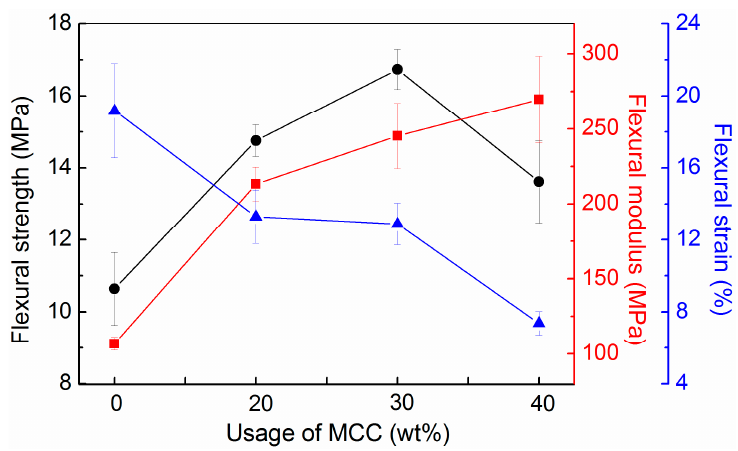
Figure 4. Effect of MCC loading on the flexural properties of MCC/AESO composites. ( Flexural strength; Figure 4. E ff ect of MCC loading on the fl exural properties of MCC/AESO composites. ( ● Flexural (cid:4) Flexural modulus; (cid:78) Flexural strength; ■ Flexural modulus; ▲ Flexural strain).